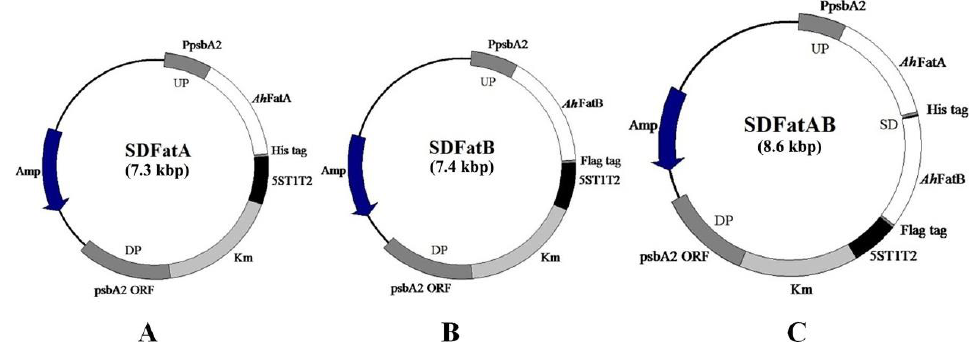
Figure 1. Structure of homologous recombination vectors harboring thioesterase genes from Arachis hypogaea L. Fat genes ( AhFatA , AhFatB , or both AhFatA and AhFatB ) were cloned into the pBluescript II SK (+) plasmid. The psbA2 promoter (P psbA2 ), consisting of the 0.5-kb fragment upstream (UP) of psbA2, the kanamycin resistance cassette (Km), the 1.0-kb fragment downstream of psbA2 ( psbA2 ORF, DP), and the E. coli 5ST1T2 terminator were also cloned into the plasmids. Amp: ampicillin resistance cassette. ( A ) SD FatA , for the heterologous expression of AhFatA tailed with a His tag; ( B ) SD FatB , for the heterologous expression of AhFatB tailed with a Flag-tag; ( C ) SD FatAB , tandem expression of AhFatA tailed with a His tag and AhFatB tailed with a Flag-tag.